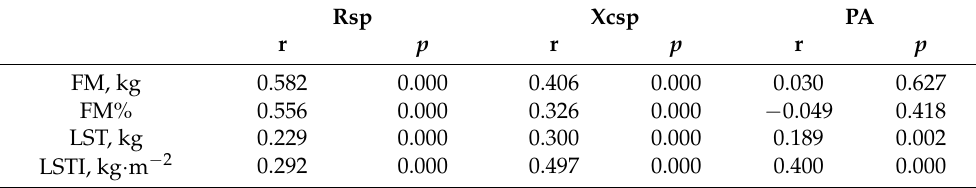
Table 2. Matrix of correlation between bioelectric and DXA variables (N = 270) at baseline.